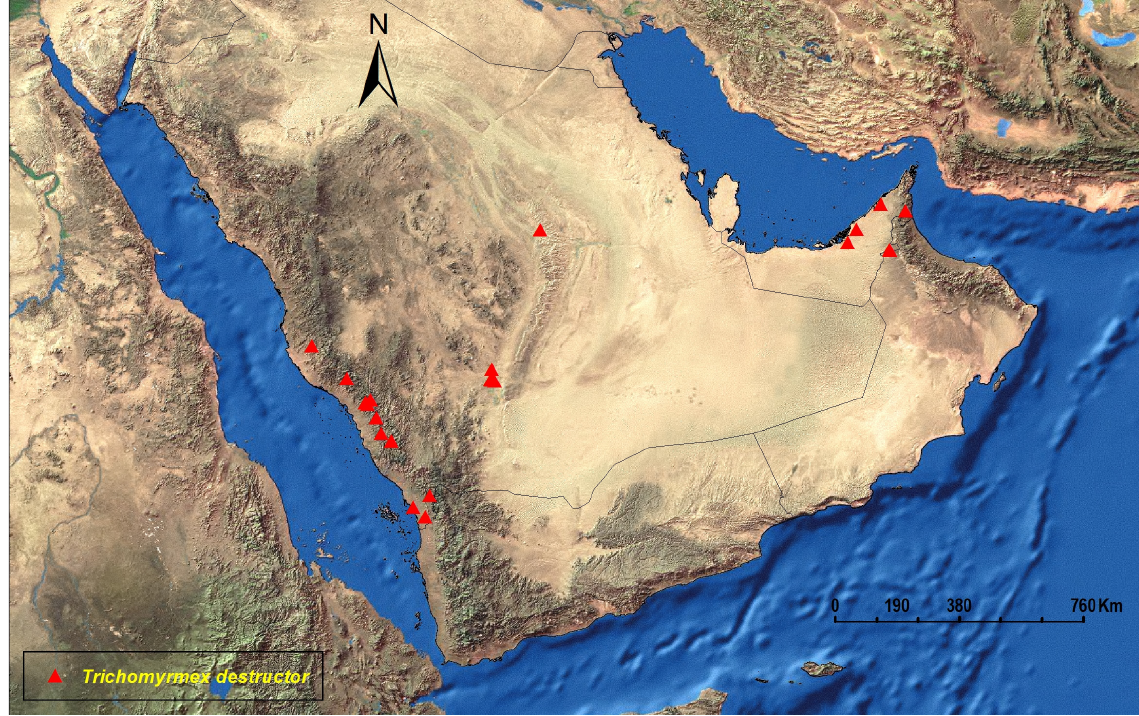
Fig. 15. Distribution map of Trichomyrmex destructor (Jerdon,